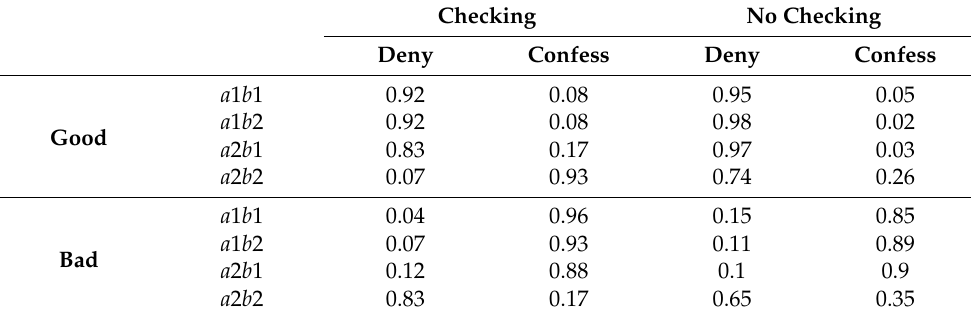
Table 5. Observed probabilities for all question combinations in Experiment 1 ( n = 100 for each cell), split by decision to deny or confess and whether participants checked or not.